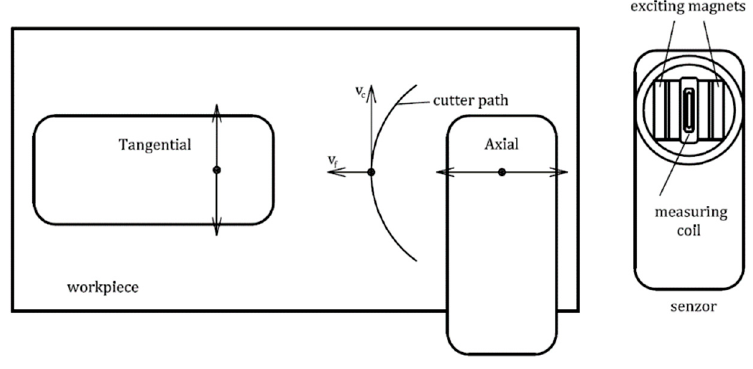
Figure 3. MBN sensor positioning.